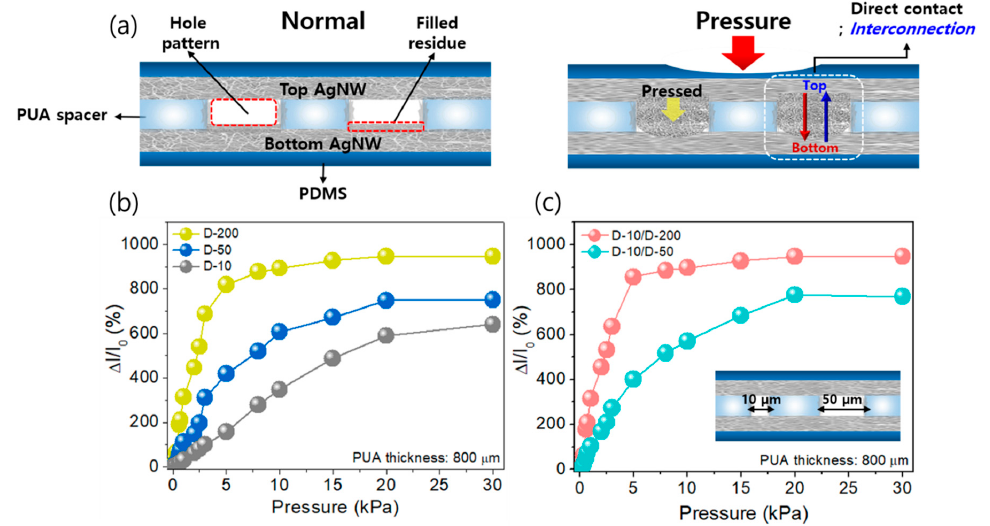
Figure 2. The sensing mechanism and analysis of static response to pressure and the electrical characteristics. ( a ) Simple schematics of the pressure sensing mechanism. ( b , c ) The relative current change of single hole patterned pressure sensor (D-10, 50 and 200 µm) and multi-mixed holes patterned pressure sensor (D-10/50 and 10/200) in a large pressure range (0.1–30 kPa) .